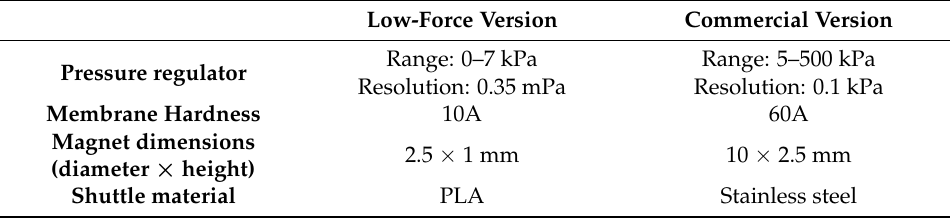
Table 1. Differences between the low-force and commercial MCTR bioreactor.